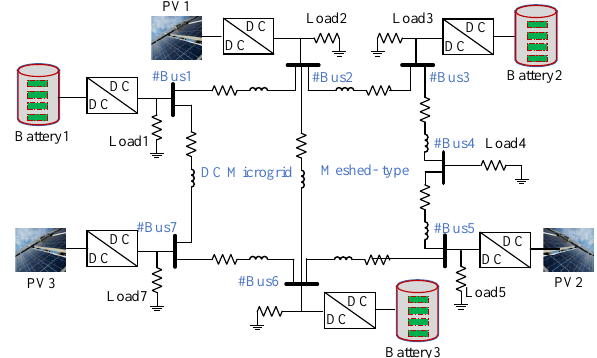
Figure 10. Seven-bus meshed-type DC microgrid